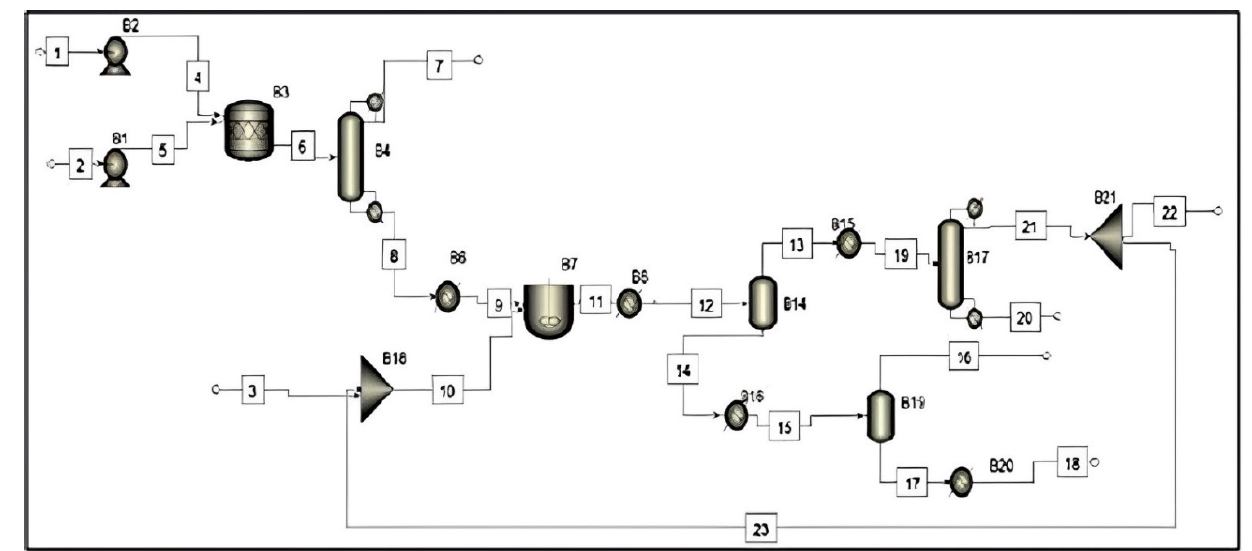
Figure 2. Biodiesel Production Process.